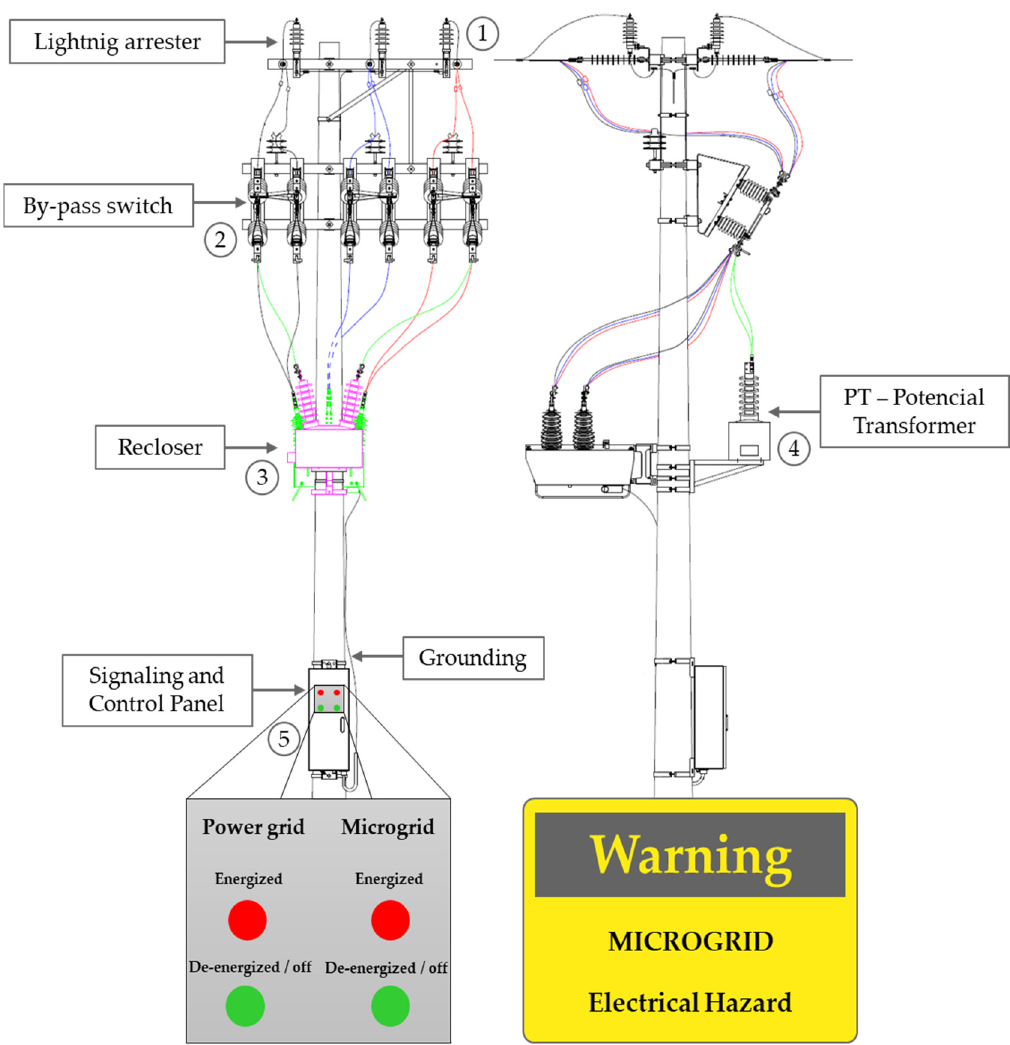
Figure 9. Standard structure proposed for microgrid connection—point of connection at medium voltage, protections implanted using relay and recloser.